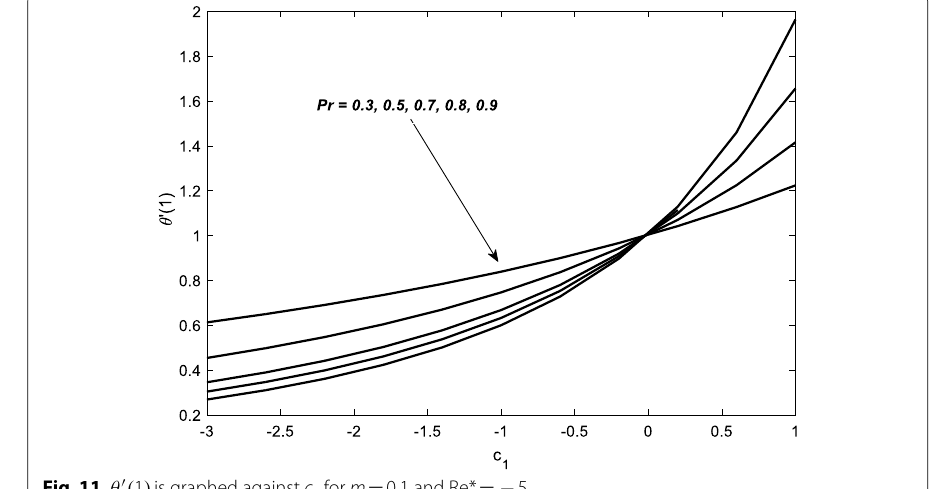
Fig. 11 θ ′ ( 1 ) is graphed against c 1 for m